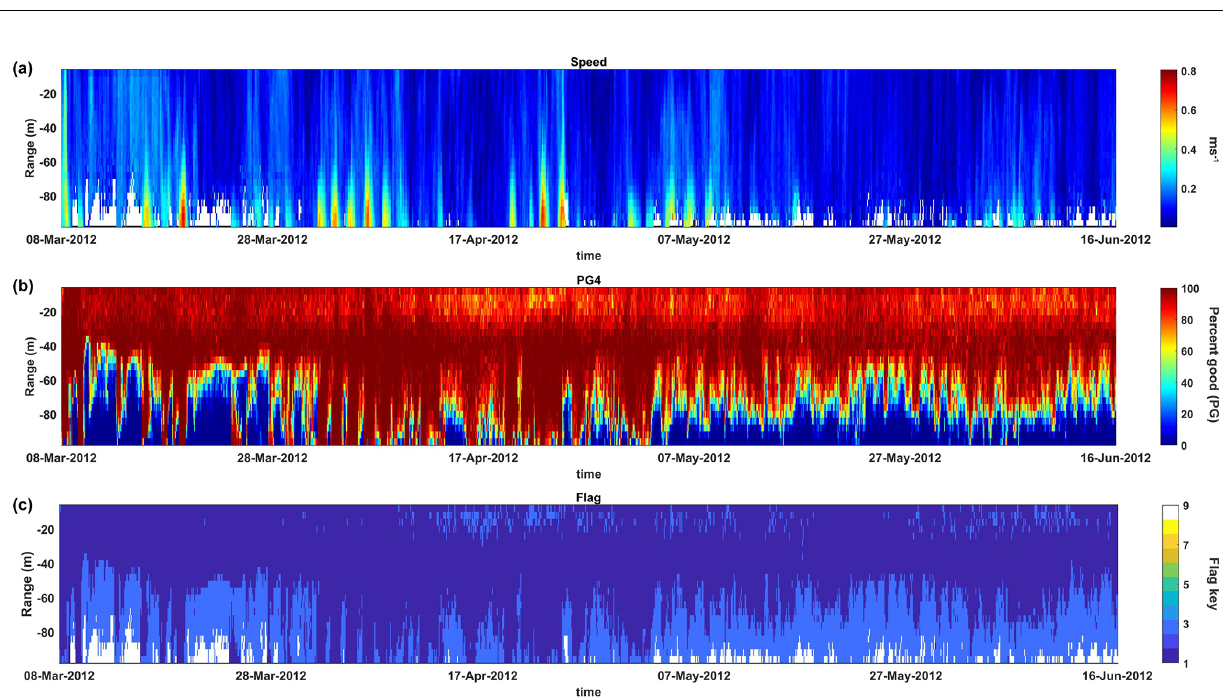
Figure 2. Schematic of the quality control procedure: in (a) , the original current velocity data are represented, in (b) , the value of the percent good parameter calculated for each cell is represented, and in (c) , the key of the qualifier flag assigned for each observation is represented. For better visualisation, only part of the time series has been